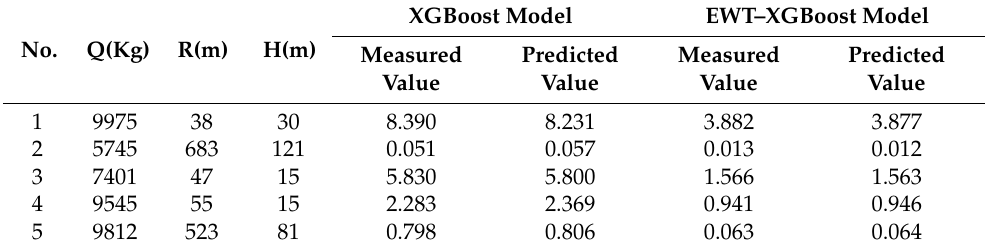
Table 5. Test sample data and comparison of forecast results.